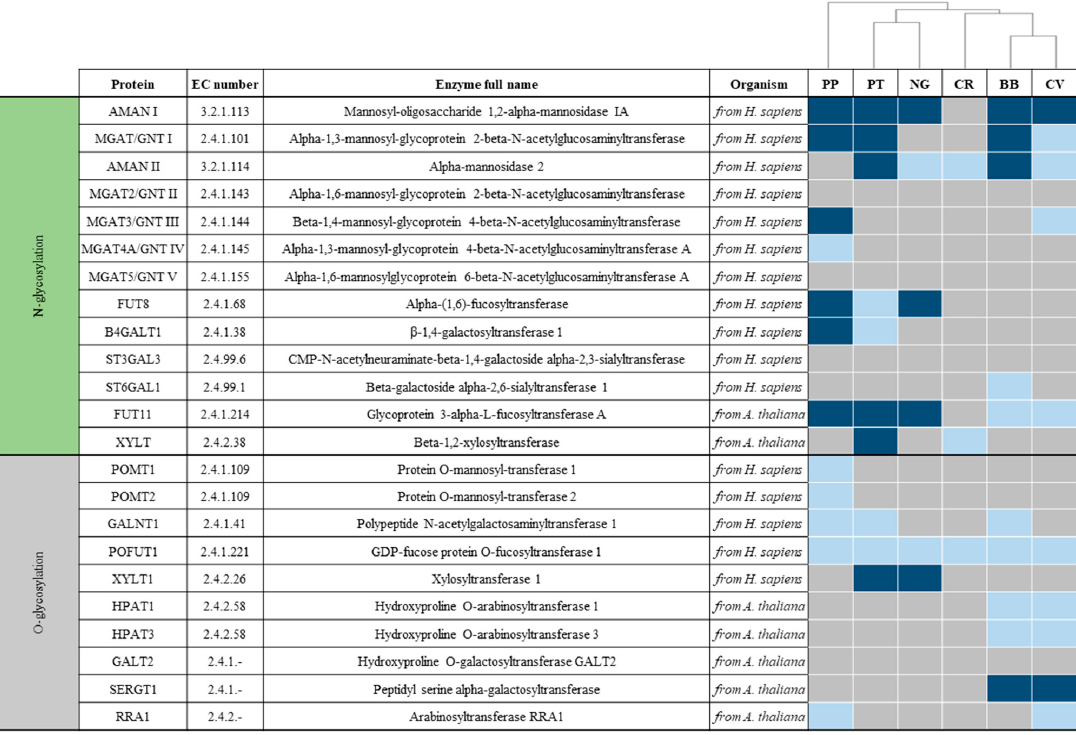
Figure 3. Hypothetical presence of protein N- glycosylation and O- glycosylation enzymes in the representative microalgal species, P. purpureum (PP), P. tricornutum (PT), Nannochloropsis gaditana (NG), C. reinhardtii (CR), B. braunii (BB), and C. vulgaris (CV), compared with glycosylation enzymes from H. sapiens and A. thaliana . Enzymes are classified as present (dark blue) , potentially present (light blue) or missing (grey).